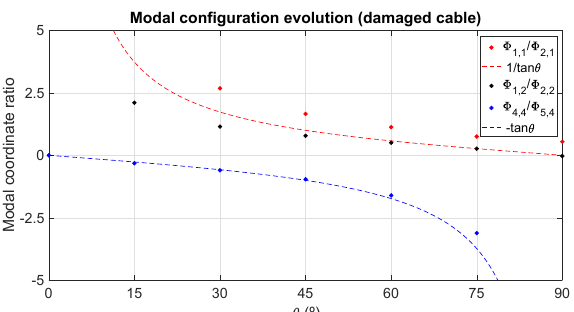
Figure 6. Relation between surge and sway modal coordinates for the first (in red) and second (in black) modes and between the pitch and roll modal coordinates for the rotational mode (in blue) considering the damaged cable.